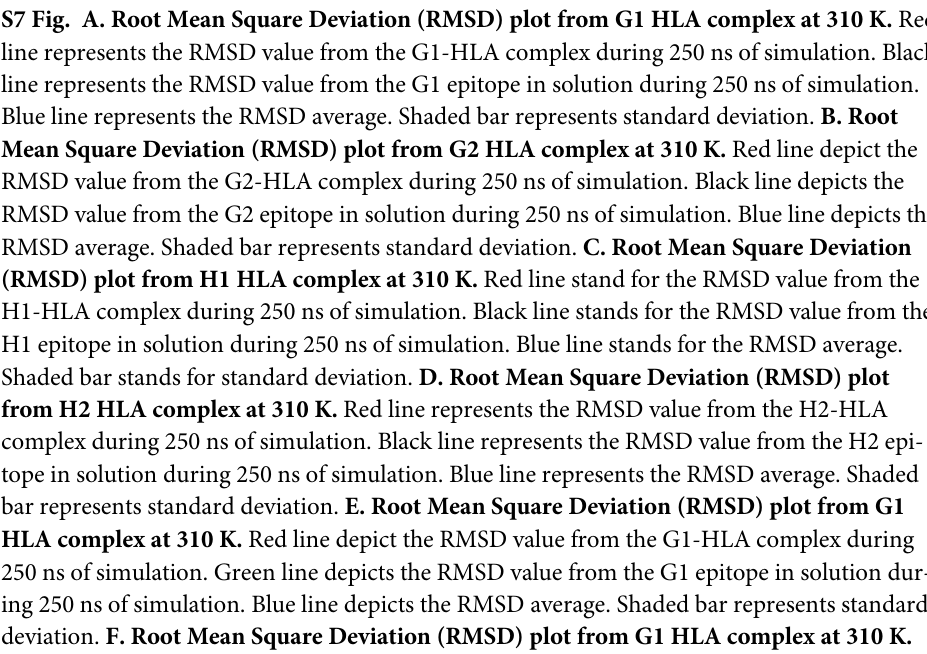
depict the RMSD value during 5 ns of simulation. Blue line depicts the RMSD average. Shaded bar depicts standard deviation. D. Root Mean Square Deviation (RMSD) plot from EsxG EsxH complex at 550 K. Red line represents the RMSD value during 5 ns of simulation. Blue line represents the RMSD average. Shaded bar represents standard deviation. E. Radius of Gyration (RoG) plot from EsxG EsxH complex at 400 K. Red line stand for RoG value dur- ing 5 ns of simulation. Blue line stands for the RoG average. Shaded bar stands for standard deviation. F. Radius of Gyration (RoG) plot from EsxG EsxH complex at 450 K. Red line represents RoG value during 5 ns of simulation. Blue line represents the RoG average. Shaded bar represents standard deviation. G. Radius of Gyration (RoG) plot from EsxG EsxH com- plex at 500 K. Red line depict RoG value during 5 ns of simulation. Blue line depicts the RoG average. Shaded bar represents standard deviation. H. Radius of Gyration (RoG) plot from EsxG EsxH complex at 550 K. Red line represents RoG value during 5 ns of simulation. Blue line represents the RoG average. Shaded bar represents standard deviation. (TIF) S6 Fig. A. Secondary structure plot from EsxG EsxH complex at 400 K. Residues 1 to 97 depict EsxG monomer, residues 98 to 194 depict EsxH monomer. B. Secondary structure plot from EsxG EsxH complex at 450 K. Residues 1 to 97 depict EsxG monomer, residues 98 to 194 represents EsxH monomer. C. Secondary structure plot from EsxG EsxH complex at 500 K. Residues 1 to 97 stand for EsxG monomer, residues 98 to 194 stand for EsxH monomer. D. Secondary structure plot from EsxG EsxH complex at 550 K. Residues 1 to 97 represents EsxG monomer, residues 98 to 194 represents EsxH monomer. E. Hydrogen bonds plot from EsxG EsxH complex at 400 K. Black line depict total hydrogen bonds during 5 ns of simula- tion. F. Hydrogen bonds plot from EsxG EsxH complex at 450 K. Black line depict total hydrogen bonds during 5 ns of simulation. G. Hydrogen bonds plot from EsxG EsxH com- plex at 500 K. Black line stand for total hydrogen bonds during 5 ns of simulation. H. Hydro- gen bonds plot from EsxG EsxH complex at 550 K. Black line stand for total hydrogen bonds during 5 ns of simulation. (TIF) S7 Fig. A. Root Mean Square Deviation (RMSD) plot from G1 HLA complex at 310 K. Red line represents the RMSD value from the G1-HLA complex during 250 ns of simulation. Black line represents the RMSD value from the G1 epitope in solution during 250 ns of simulation. Blue line represents the RMSD average. Shaded bar represents standard deviation. B. Root Mean Square Deviation (RMSD) plot from G2 HLA complex at 310 K. Red line depict the RMSD value from the G2-HLA complex during 250 ns of simulation. Black line depicts the RMSD value from the G2 epitope in solution during 250 ns of simulation. Blue line depicts the RMSD average. Shaded bar represents standard deviation. C. Root Mean Square Deviation (RMSD) plot from H1 HLA complex at 310 K. Red line stand for the RMSD value from the H1-HLA complex during 250 ns of simulation. Black line stands for the RMSD value from the H1 epitope in solution during 250 ns of simulation. Blue line stands for the RMSD average. Shaded bar stands for standard deviation. D. Root Mean Square Deviation (RMSD) plot from H2 HLA complex at 310 K. Red line represents the RMSD value from the H2-HLA complex during 250 ns of simulation. Black line represents the RMSD value from the H2 epi- tope in solution during 250 ns of simulation. Blue line represents the RMSD average. Shaded bar represents standard deviation. E. Root Mean Square Deviation (RMSD) plot from G1 HLA complex at 310 K. Red line depict the RMSD value from the G1-HLA complex during 250 ns of simulation. Green line depicts the RMSD value from the G1 epitope in solution dur- ing 250 ns of simulation. Blue line depicts the RMSD average. Shaded bar represents standard deviation. F. Root Mean Square Deviation (RMSD) plot from G1 HLA complex at 310